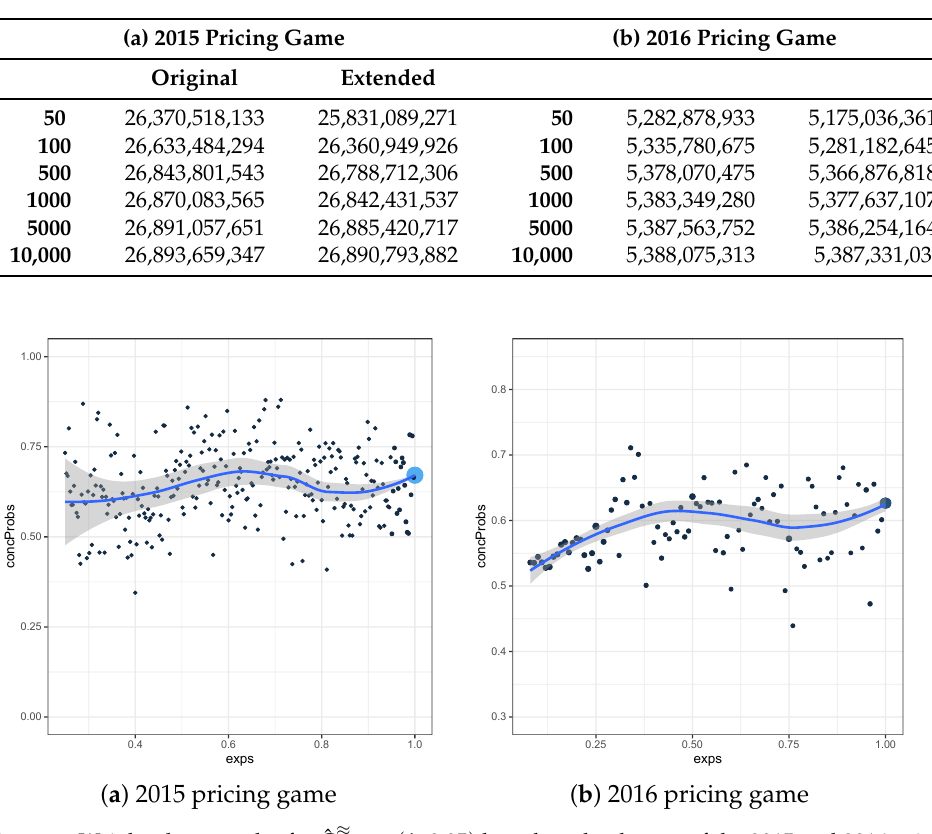
Table 6. Number of comparable pairs used in the original and extended marginal approximation of ( 0.05 ) on the bootstrap of the predictions and observations of the 2015 and 2016 pricing game C ≈ 0,1 + dataset. This is done for several different numbers of boundary values.